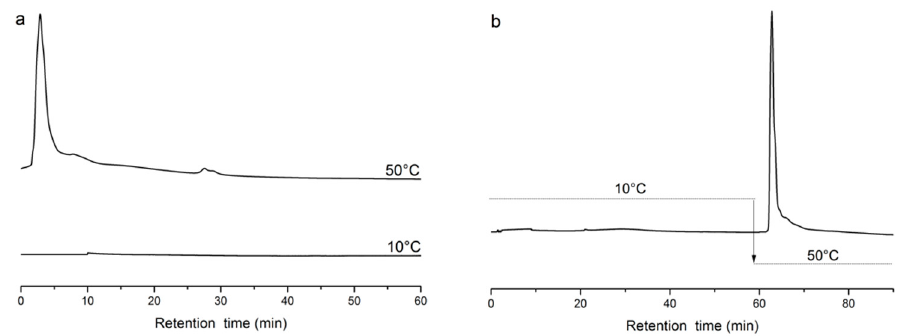
Figure 6. Chromatograms of protamine using a poly(NIPAAm- co -AAc- co -tBAAm)-grafted silica column. ( a ) Chromatogram of protamine at 10 and 50 ◦ C; ( b ) injecting the sample at 10 ◦ C and increasing temperature to 50 ◦ C at 60 min, flow rate 0.1 mL / min, detection wavelength 280 nm, sample size 5 µ